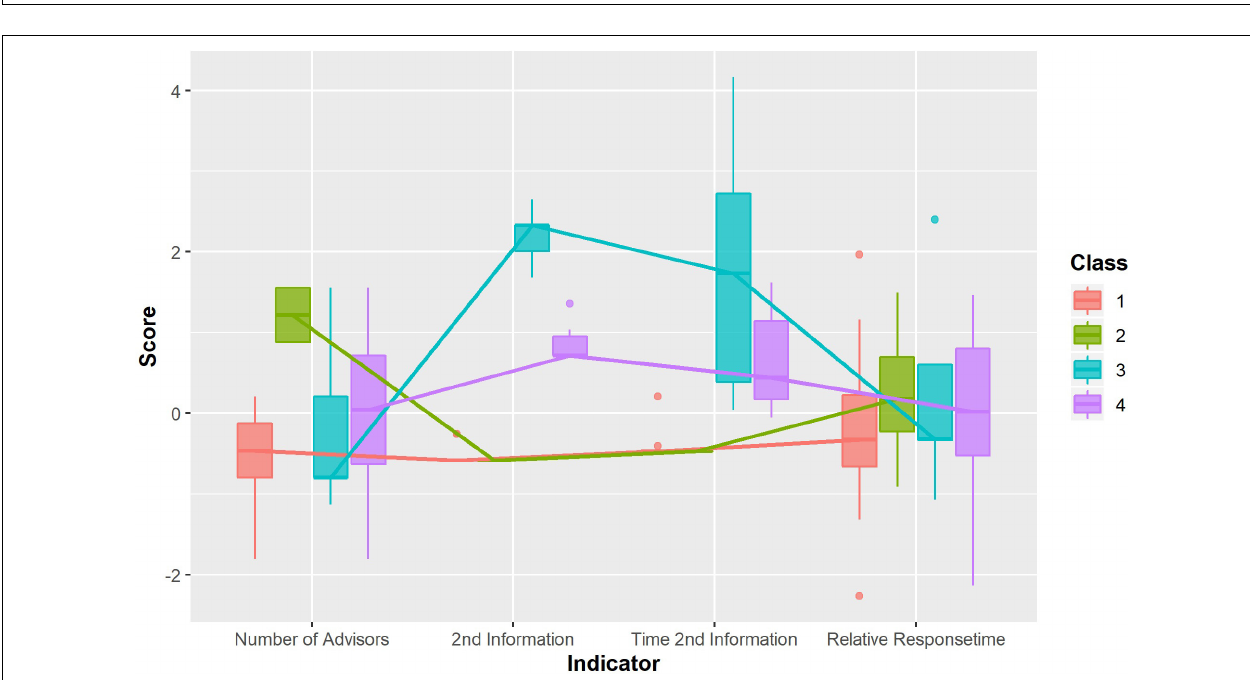
FIGURE 2 | Gameplay profiles for Standard 1.